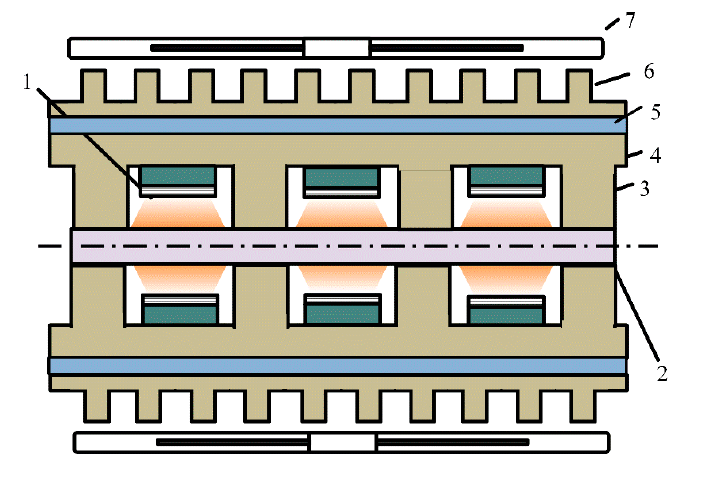
Figure 1. Segmented circular laser diode (LD) array side-pumping